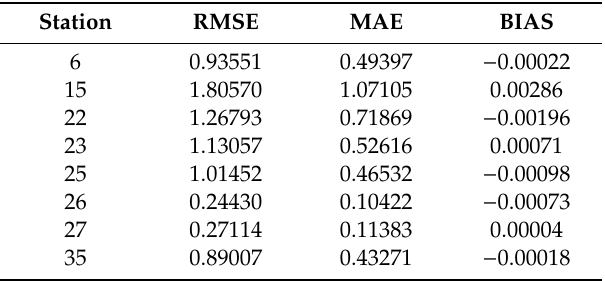
Table 4. RMSE, MAE and bias values in each station for MARS models (RMSE: root mean squared error, MAE: mean absolute error, BIAS: bias or historial average error, MARS: multivariate adaptive regression splines).